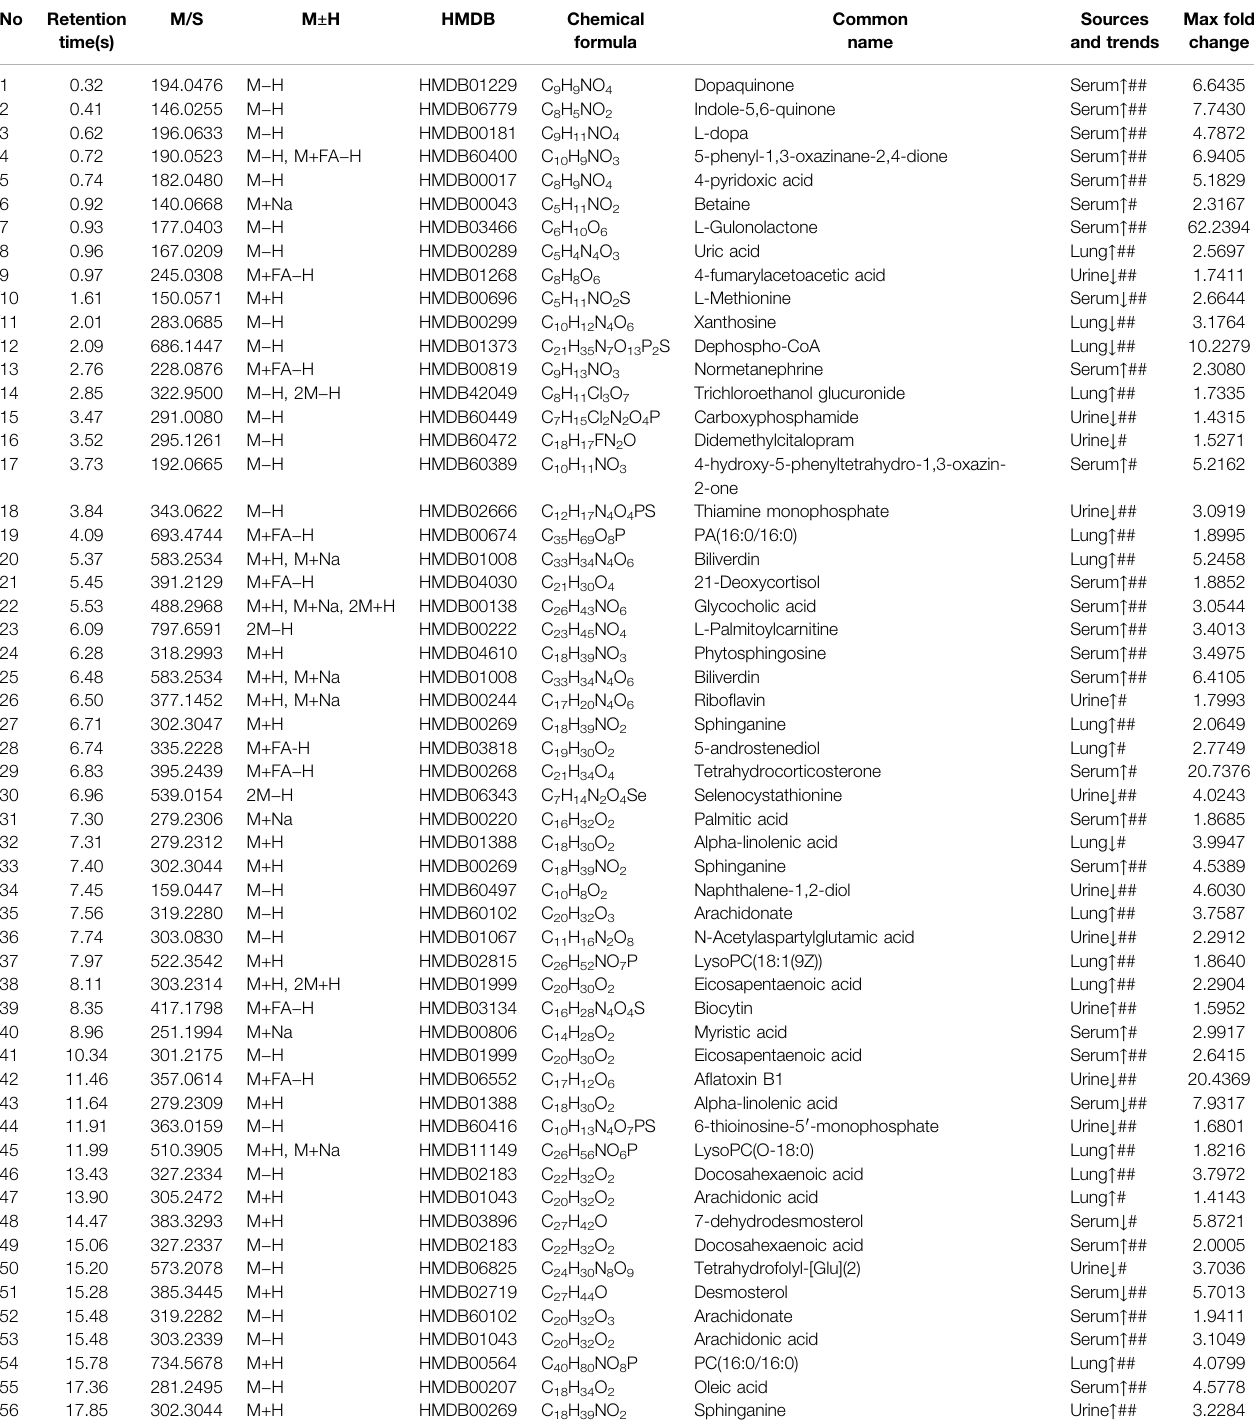
TABLE 1 | Urine, serum, and lung tissue have a tendency to pull back